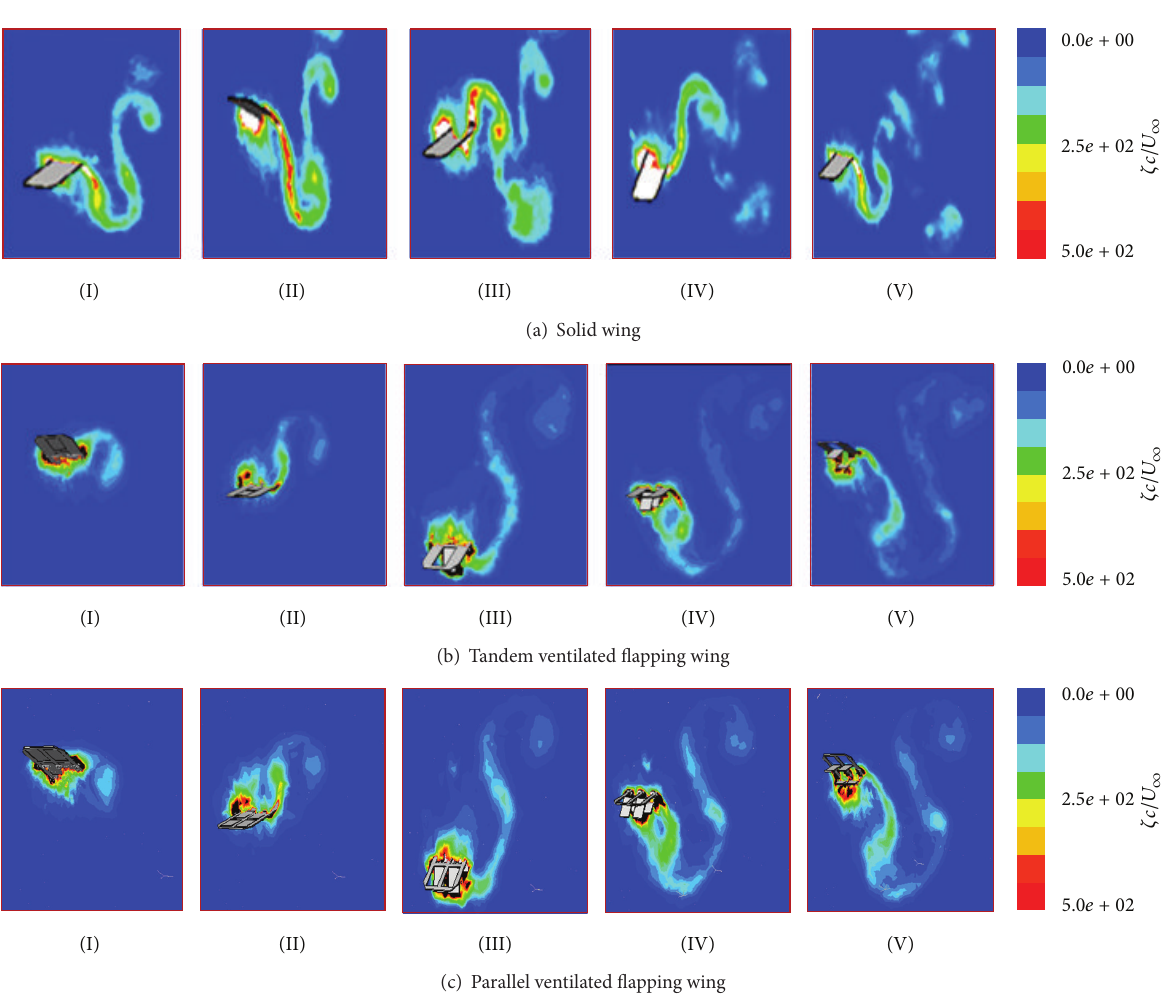
and stayed attached to the leading edge of the flapping